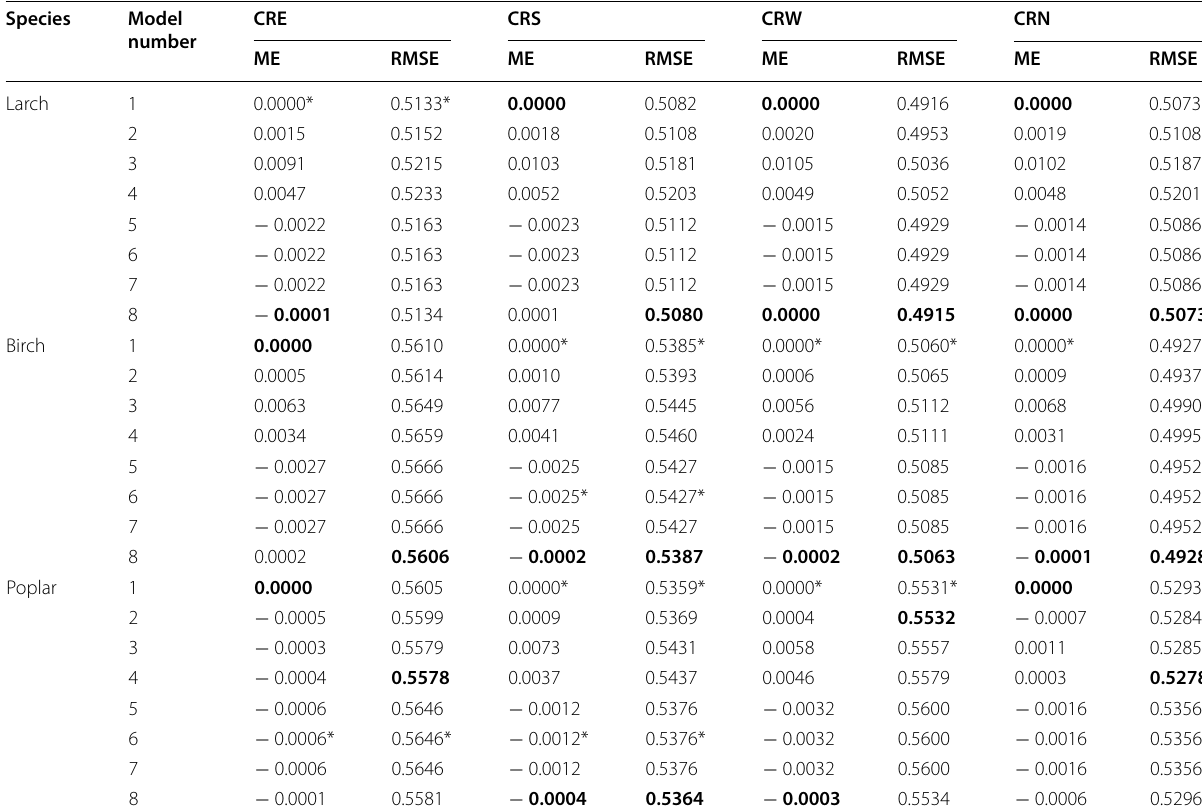
Table 3 Fit statistics of the candidate basic models for CR of larch, birch, and poplar